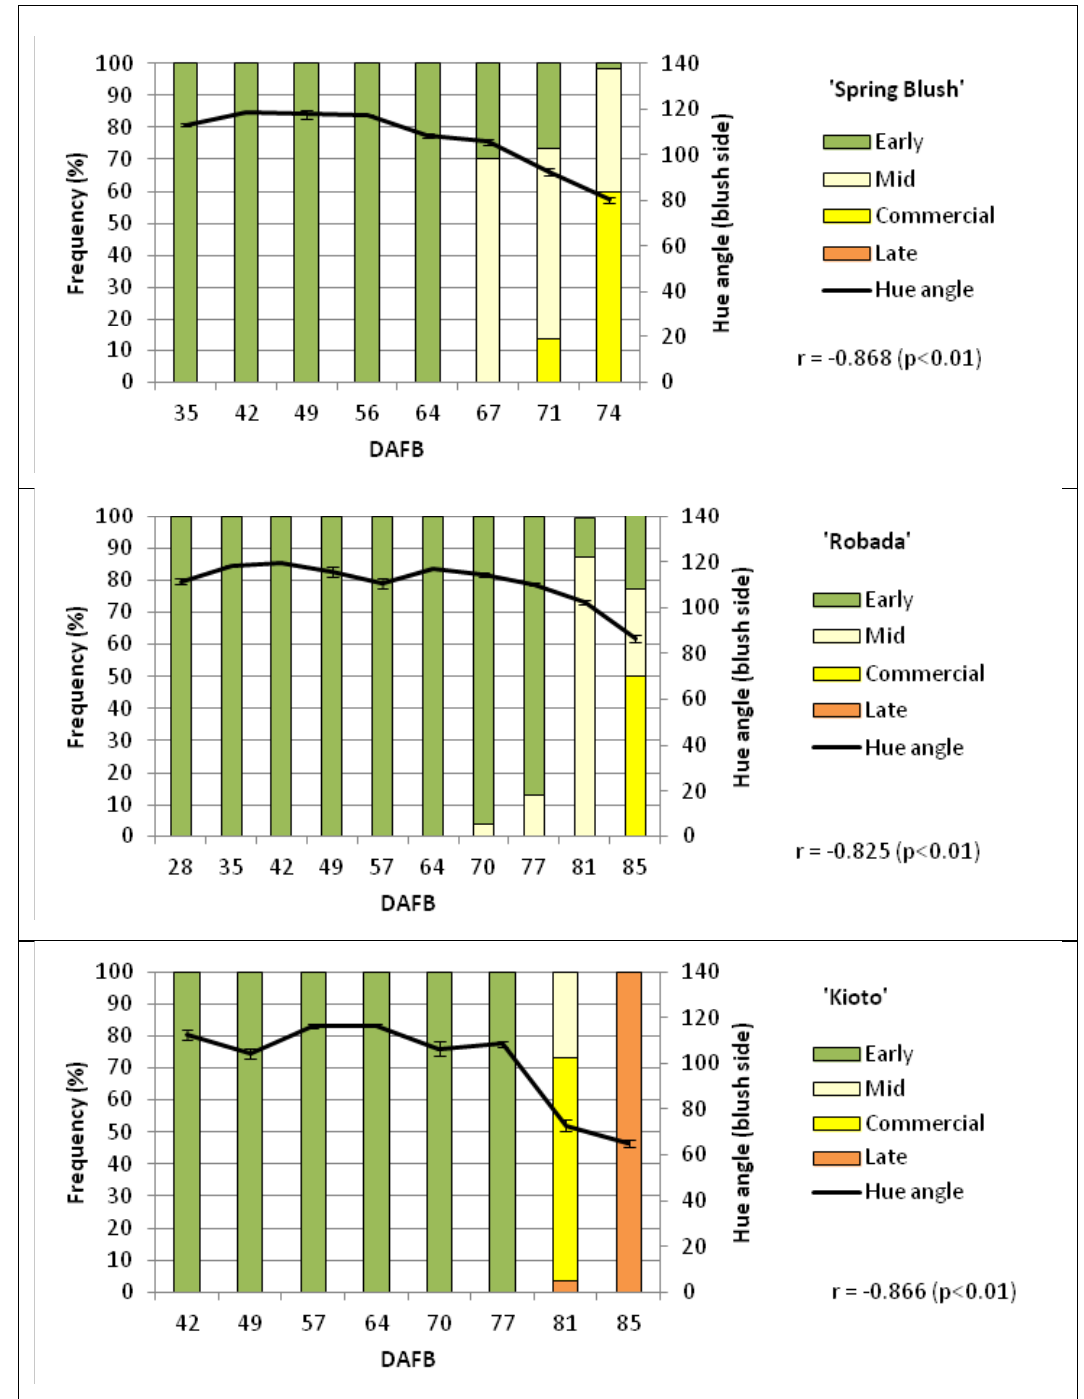
Figure 2. Relationship between instrumental colour (hue) and the state of visual maturity of the fruit, established by CTIFL colour, for the three apricot cultivars from full bloom to maturity on the tree. Mean values ± standard error (n = 20).